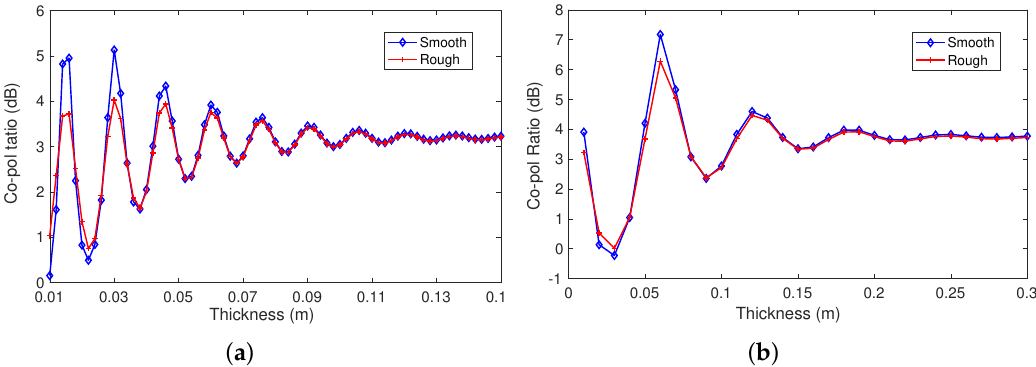
Figure 9. Co-polarization ratio with respect to the thickness of the newly formed sea ice at an incidence angle of 40 ◦ for ( a ) C-band and ( b )